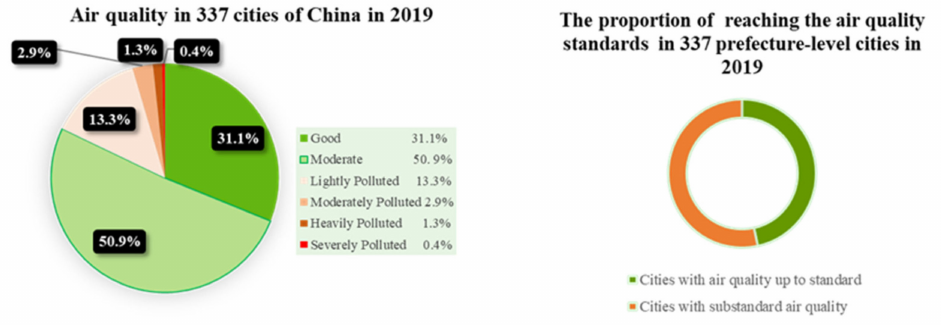
Figure 1. Proportion of air quality days at all levels and quality standards in 337 cities in